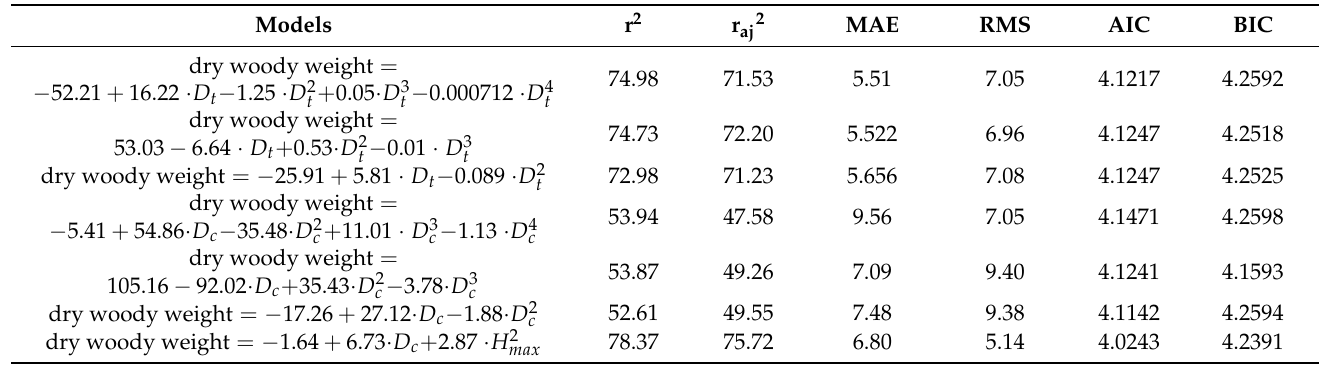
Table 7. Predictive models of citrus dry woody biomass.